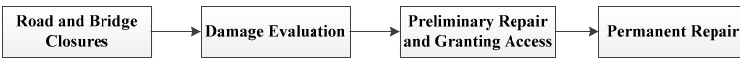
Figure 4. Transportation agencies’ disaster response processes.